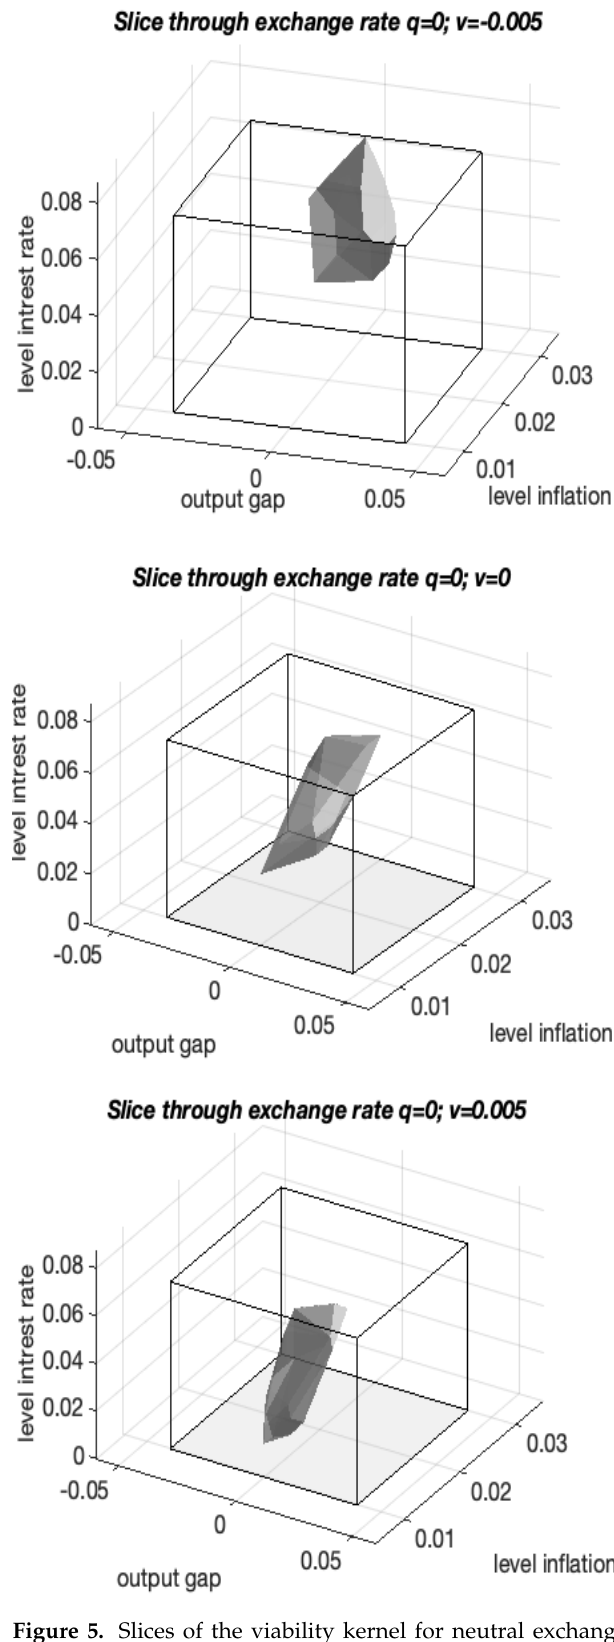
Figure 5. Slices of the viability kernel for neutral exchange rate when v = − 0.005, v = 0 and v =